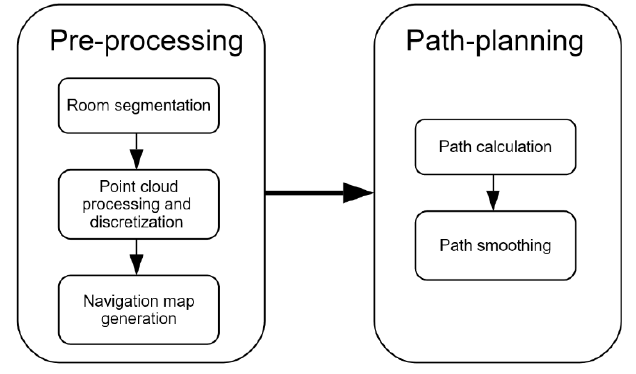
Figure 1. General workflow of the method .